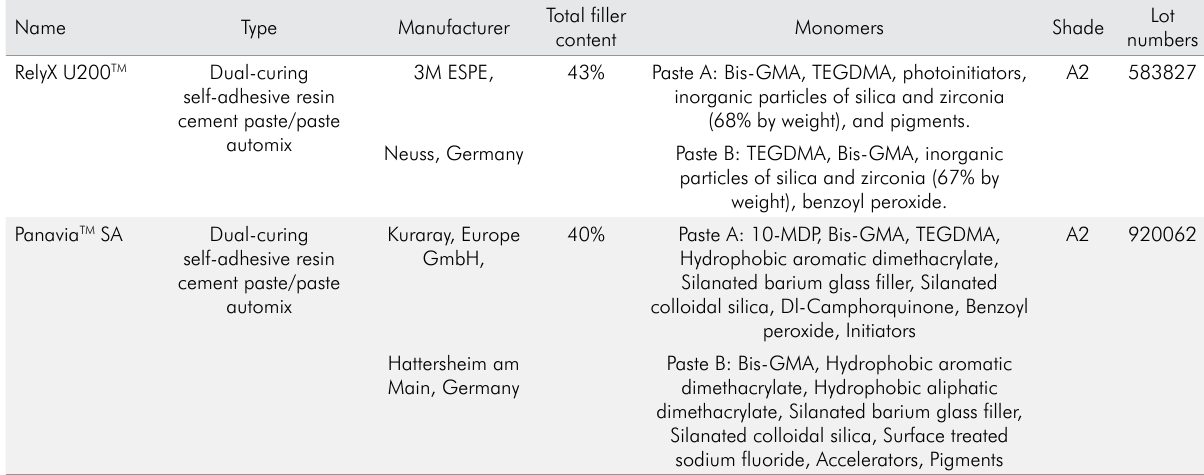
Table. Materials used in the study. Bis-GMa, Bisphenol A-diglycidylmethacrylate; MDP Monomer, 10-Methacryloyloxydecyl dihydrogen phosphate; TEGDMA, triethylene glicol